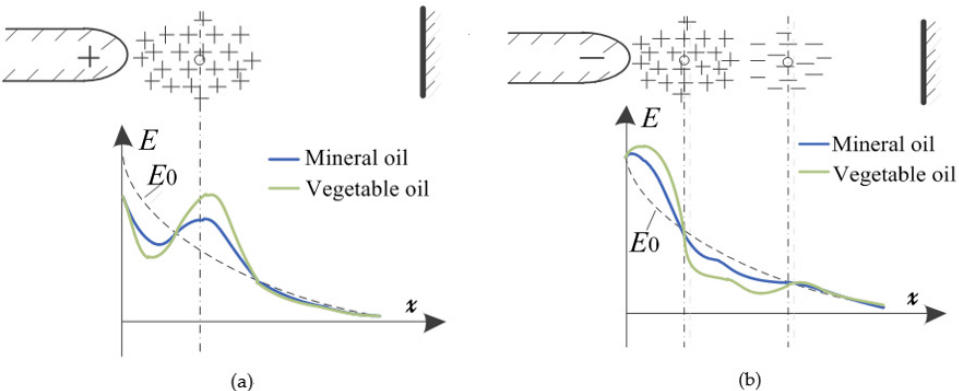
Figure 8. Polarity effect in vegetable oil and mineral oil: ( a ) positive polarity; and ( b ) negative polarity.